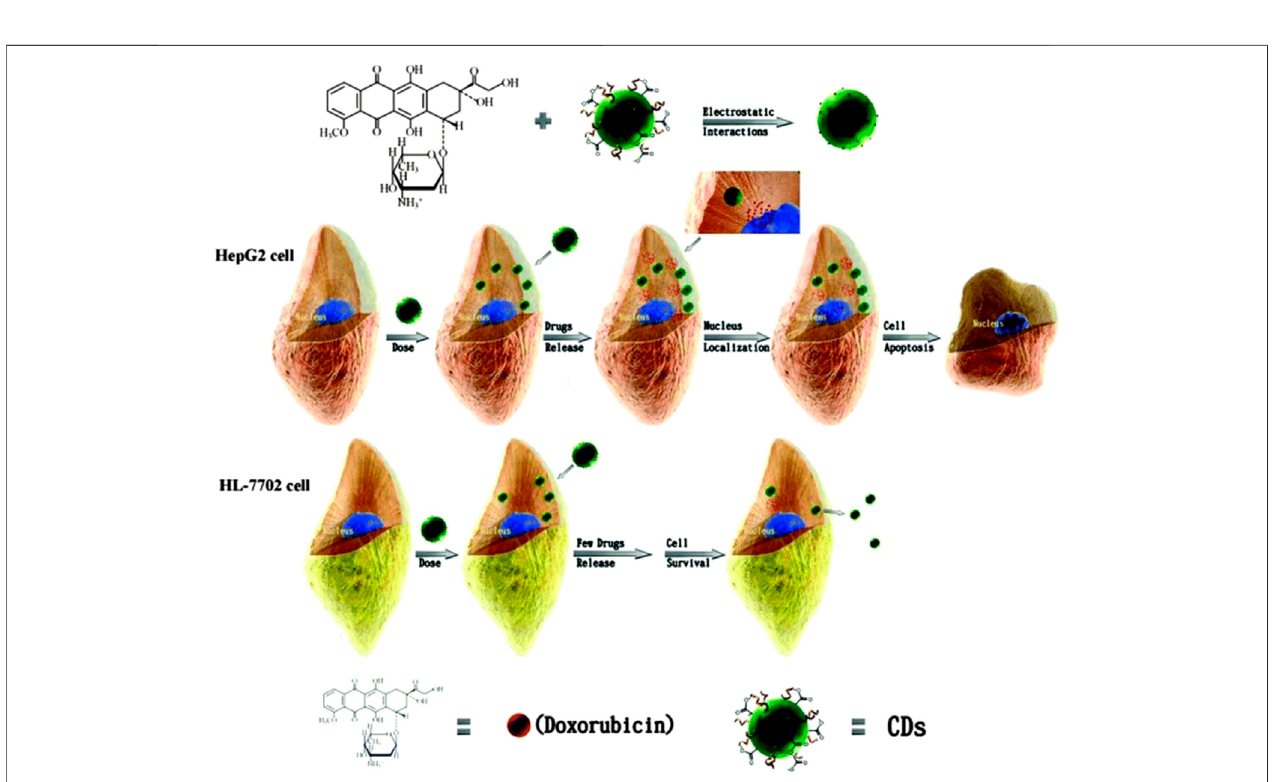
FIGURE 10 | Schematic of CQDs impact on human breast cancer (MCF-7) cell line ( Ş im ş ek et al., 2020).